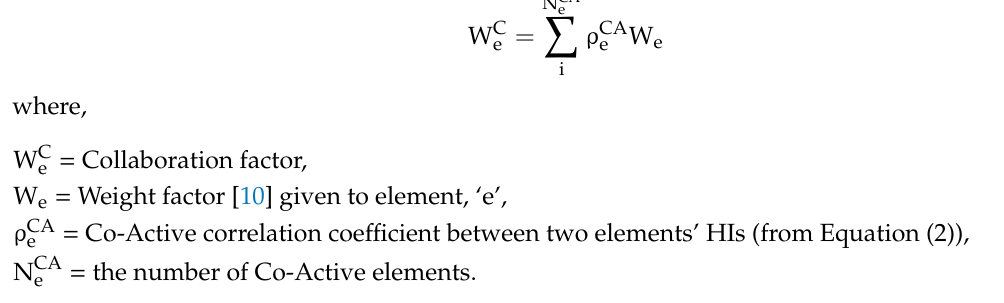
Table 4. Element health indexes by age for bridges in the ‘SO107’ group.